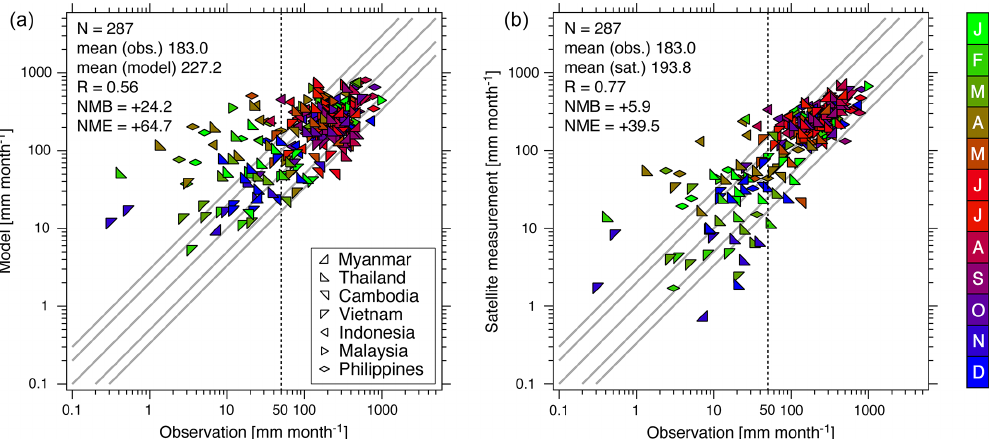
Figure 9. Scatter plots of the monthly precipitation amount over southeast Asia comparing EANET surface observations with (a) model simulations and (b) satellite measurements. Symbols indicate different countries and colors indicate different months. In the inset, the statistical metrics of mean, correlation coefficient ( R ), normalized mean bias (NMB), and normalized mean error (NME) are shown. The vertical dotted line represents observed precipitation of 50mmmonth − 1 , which defines the boundary between the dry and wet seasons in this study.